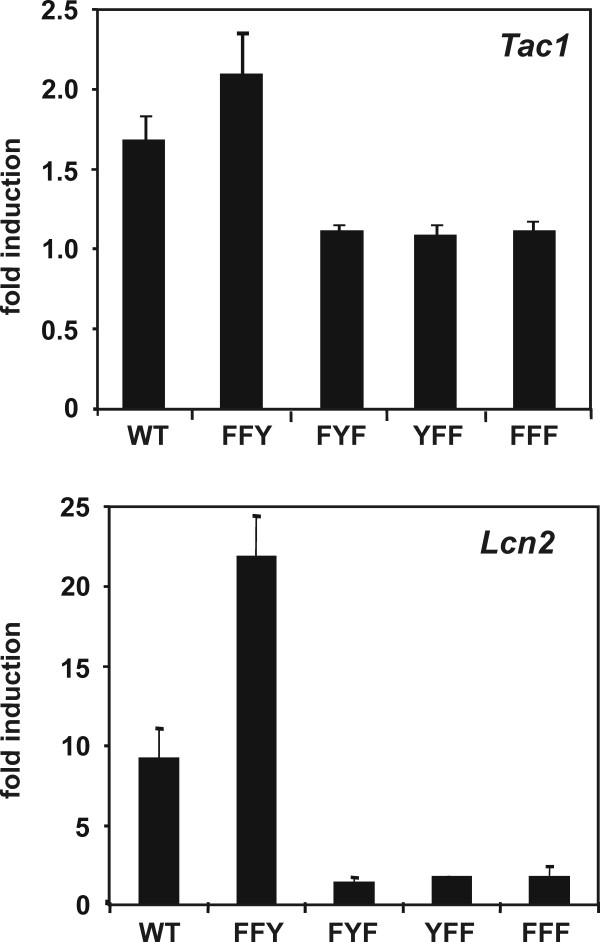
Regulation of Lcn2 and Tac1 promoter by LEPRb mutants. HIT-T15 hamster insulinoma cells were transiently transfected with luciferase constructs driven by the rat Tac1 promoter or the rat Lcn2 promoter, along with the indicated LEPRb expression plasmids. Twenty-four hours after transfection, the cells were treated with 100 ng/ml leptin or vehicle for 24 hours in serum-free medium. Luciferase activities were determined from duplicate wells and data were normalised to β-galactosidase activities. Data are expressed as fold stimulation by leptin relative to unstimulated cells. Bars reflect means +/- SD of three independent experiments (except for FFY in the upper panel which is the mean of two).